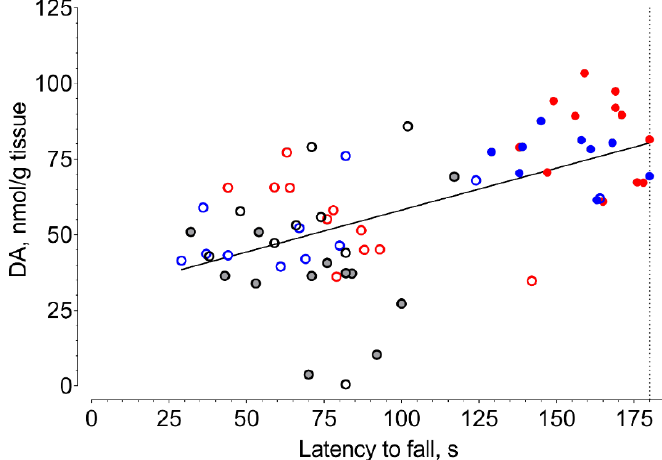
Figure 7. Correlation between striatal dopamine content of 6-OHDA-lesioned mice and their latency to fall in accelerated rotarod test (ARR). Gray dot —vehicle. Black circle —BD-1047 3.0 mg/kg. Red dot —afobazole 2.5 mg/kg. Blue dot —PRE-084 1.0 mg/kg. Red circle —BD-1047 3.0 mg/kg and afobazole 2.5 mg/kg. Blue circle —BD-1047 3.0 mg/kg and PRE-084 1.0 mg/kg. R = 0.6, p < 0.0001; line of best fit equation DA = 0.2822*X + 29.05.